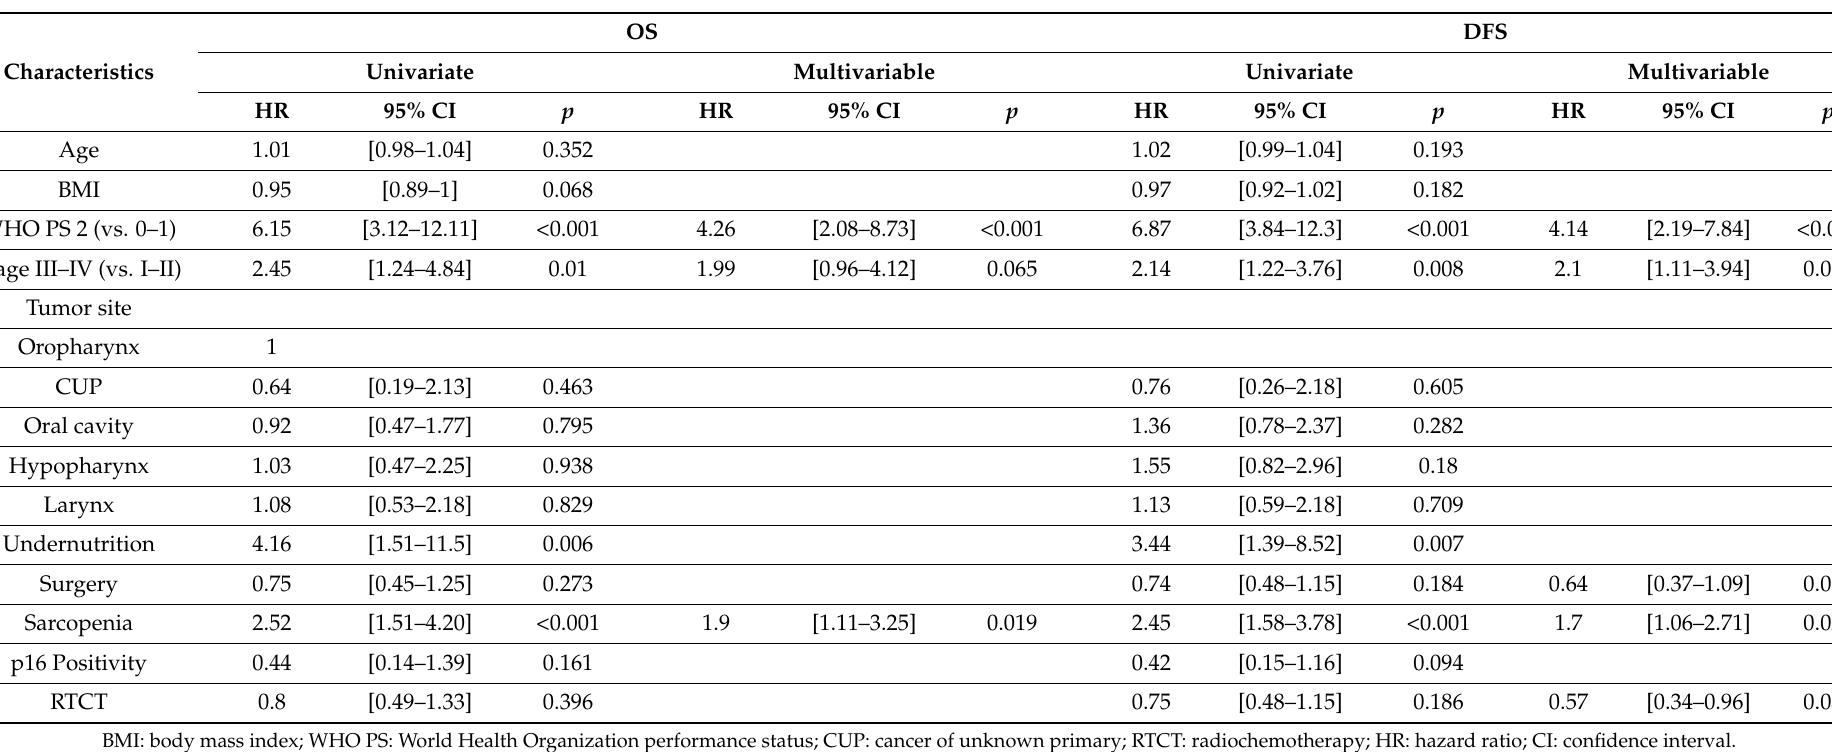
Table 3. Univariate and multivariate analyses of disease-free survival (DFS) and overall survival (OS) for the entire